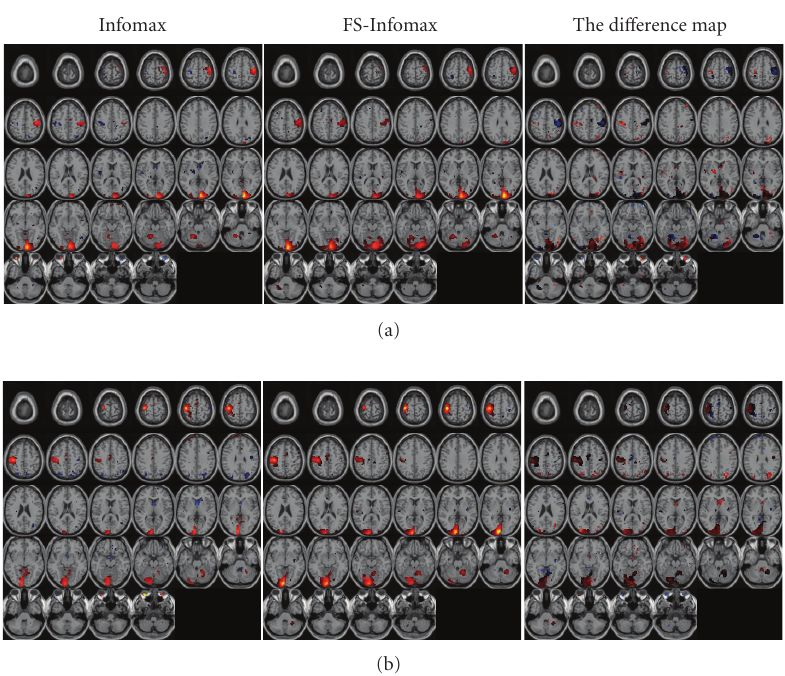
Figure 3: Activation maps of the two task-related components using group t-statistics from the group ICA results. Left : Infomax, center , FS-Infomax, right : the di ff erence map (FS-Infomax-Infomax); (a) right visuomotor activation, (b) left visuomotor activation.